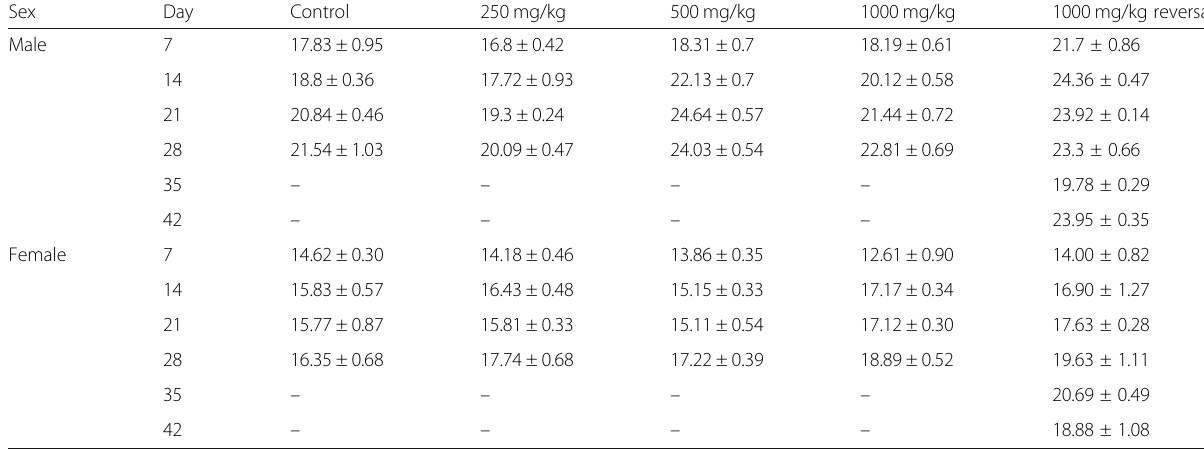
Values are expressed as mean±s.e.m. ( n =10 for each group). Data were analyzed by one-way Anova. * p <0.05 were considered as statistically significant compared to control